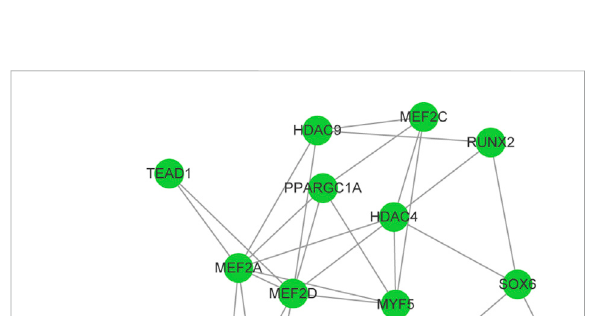
FIGURE 7 Protein-protein interaction network for the selected DEGs between SOX6 knockdown and NC CPMs. Upregulated genes are shown in red and downregulated genes are shown in blue.